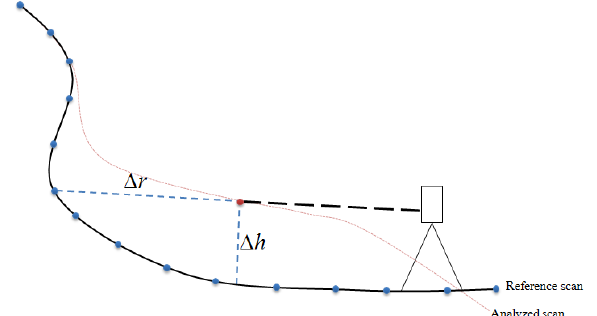
Figure 2: Referencing a point that was classified as a change – a point in the analyzed scan has been identified as a change when evaluated against a point lying on the cliff, while in fact reflecting a change against the